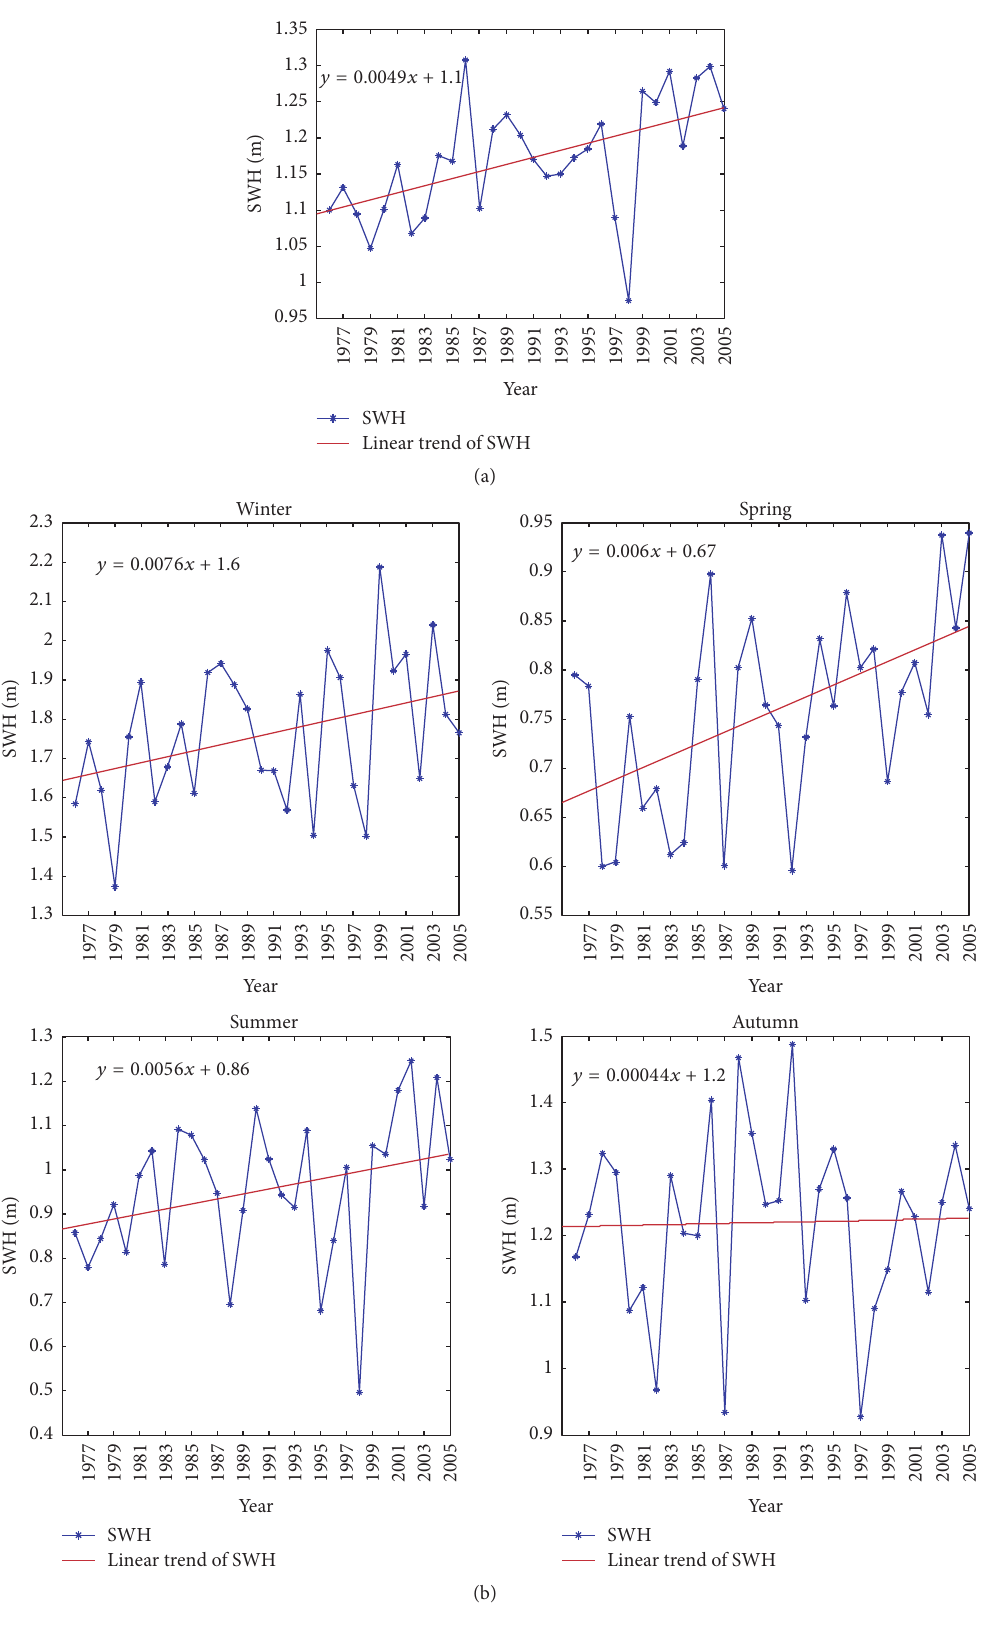
Figure 6: (a) Linear trend of annual mean SWH from year 1976 to year 2005. (b) Linear trends of seasonal mean SWH from year 1976 to year